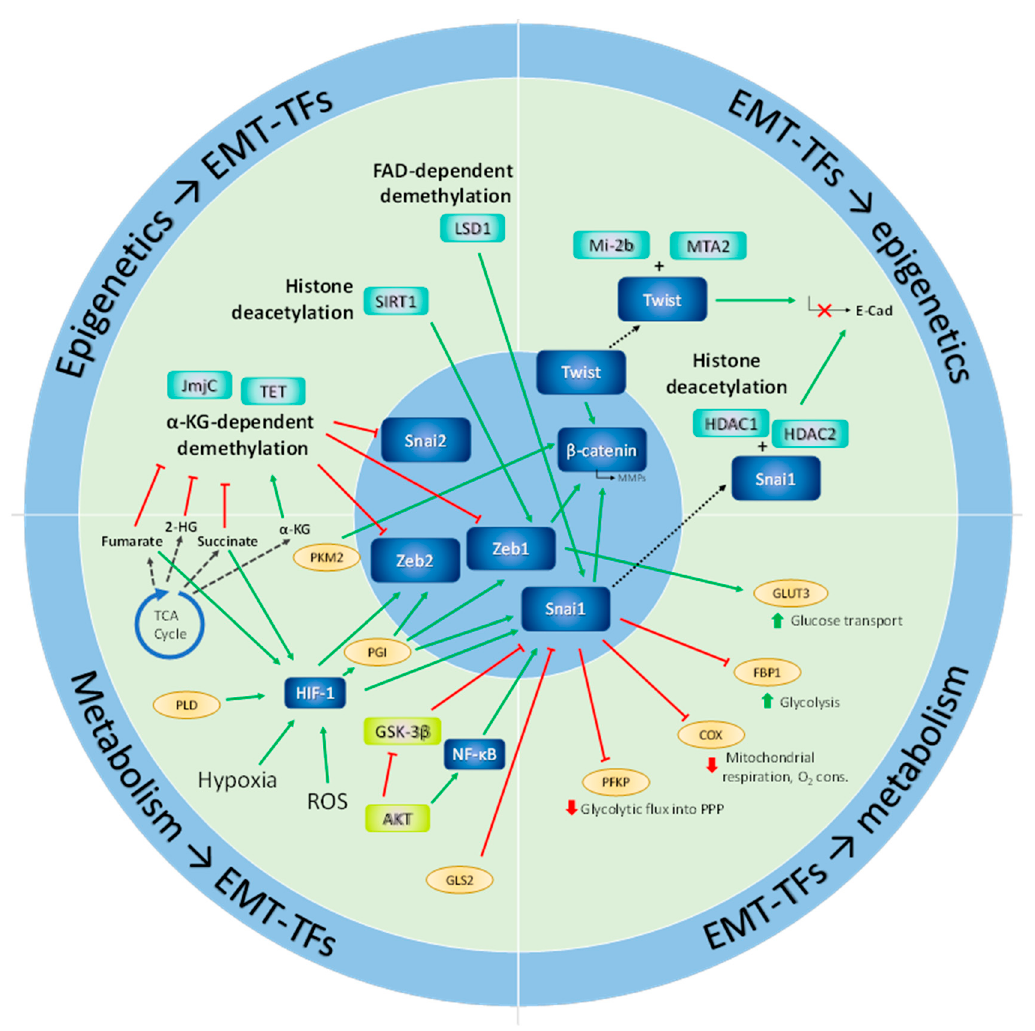
Figure 3. Relevant examples of crosstalk between metabolism, epithelial-mesenchymal plasticity and epigenetics. Epithelial-mesenchymal transition (EMT)-transcription factors (EMT-TFs) are regulated